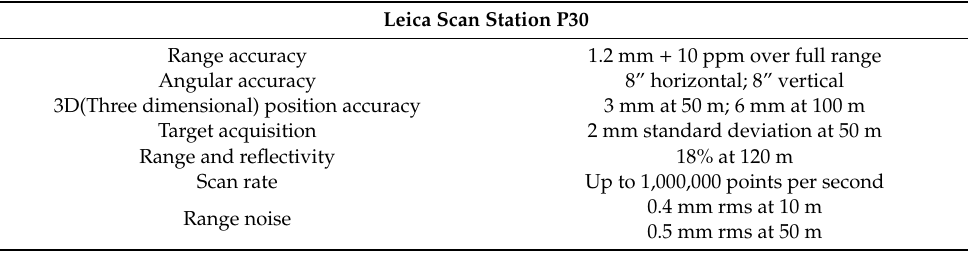
Table 2. Leica P30 laser scanner Figure 10. Leica P30 laser scanner.